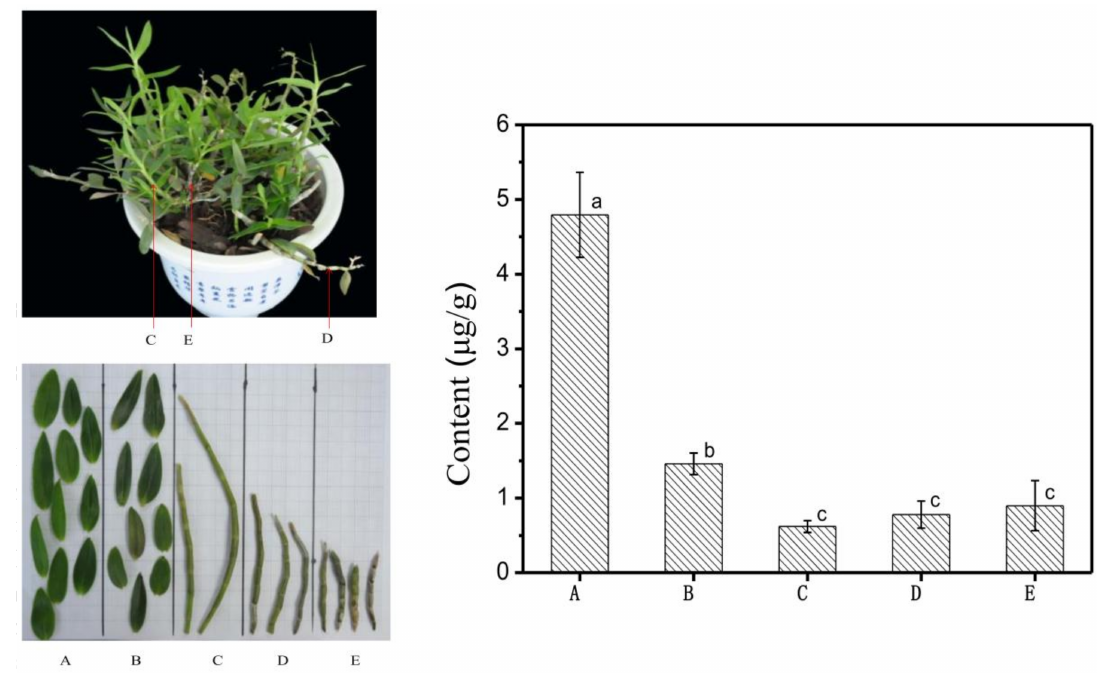
Figure 3. The content of gigantol in Dendrobium officinale at different years and in different tissues. Note: a, b and c are multiple comparison letter markings; the same letter indicates that the difference is not significant; the level of p < 0.01 indicates extremely significant; ( A ) annual leaf, ( B ) biennial leaf, ( C ) annual stem, ( D ) biennial stem, ( E ) three-year-old stem; the left figure is Dendrobium officinale cultivation and the right figure is content of